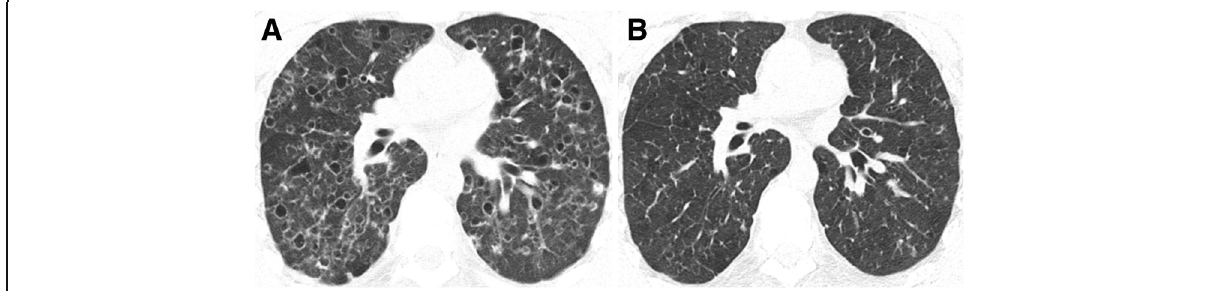
Fig. 12 PLCH. Regression of the imaging findings over time (2-year interval), after smoking cessation. a Axial CT image showing cysts with different shapes and sizes diffusely distributed in both lungs. A few cellular and mixed nodules are also present. b Axial CT image at 2-year interval showing almost complete resolution of the imagiological